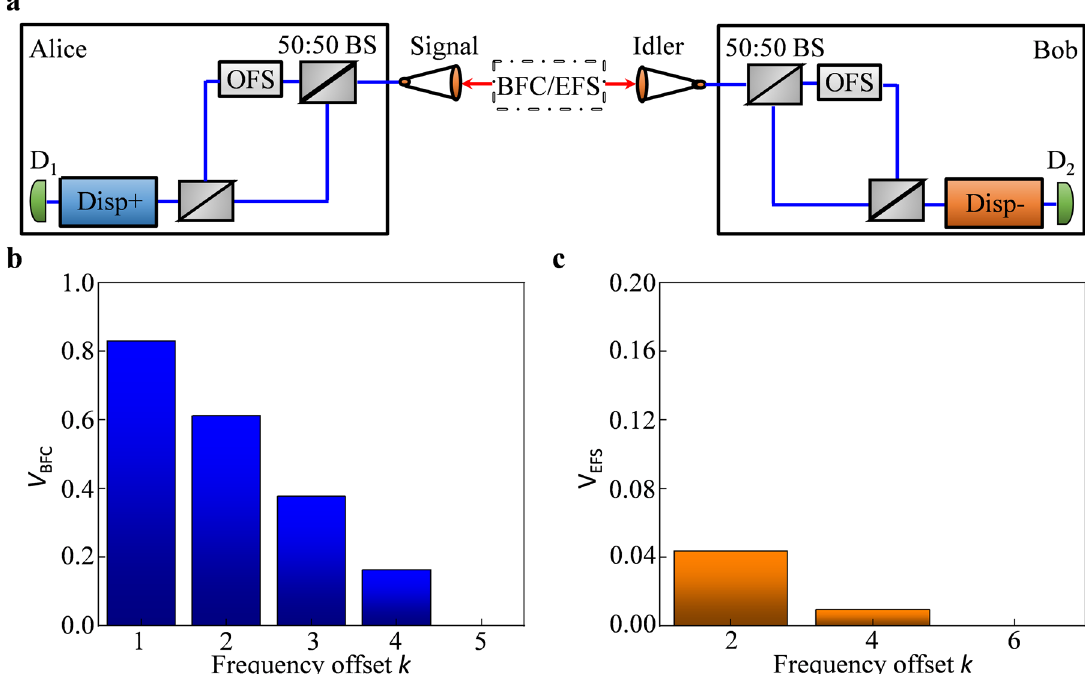
Fig. 6 Conjugate Franson interferometry and theoretical visibilities of conjugate Franson interference recurrences for the 45.32 GHz BFC and the EFS with the same JSI. a The proposed experimental setup for conjugate Franson interferometry. The signal and idler outputs from a fi ltered SPDC source are applied to a pair of MZIs. One arm of each MZI contains an OFS, i.e., a single-sideband modulator, that imposes frequency shifts þ ω m and (cid:2) ω m on the signal and idler, respectively. The MZI ’ s outputs undergo positive (for the signal) and negative (for the idler) dispersions of equal magnitude that, together with the frequency shifts, ensure there is no second-order interference present in the signal-idler coincidence counts. b BFC theoretical conjugate Franson interference has high-visibility recurrences and they occur only when the interferometer frequency offset is k ΔΩ for integer k . c EFS theoretical conjugate Franson interference has low-visibility recurrences and they only occur when the interferometer frequency offset is 2 k ΔΩ for integer k . Supplementary Discussion V describes the details of conjugate Franson interferometry, comparing the BFC and EFS recurrence visibilities for the 15.15 GHz and 5.03 GHz